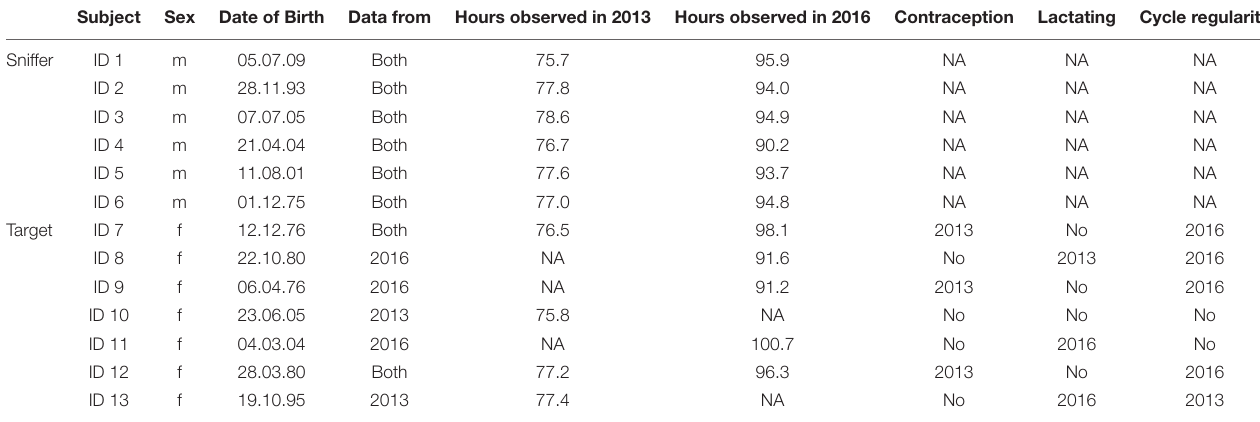
TABLE 1 | Individuals observed as sniffers (males) and targets